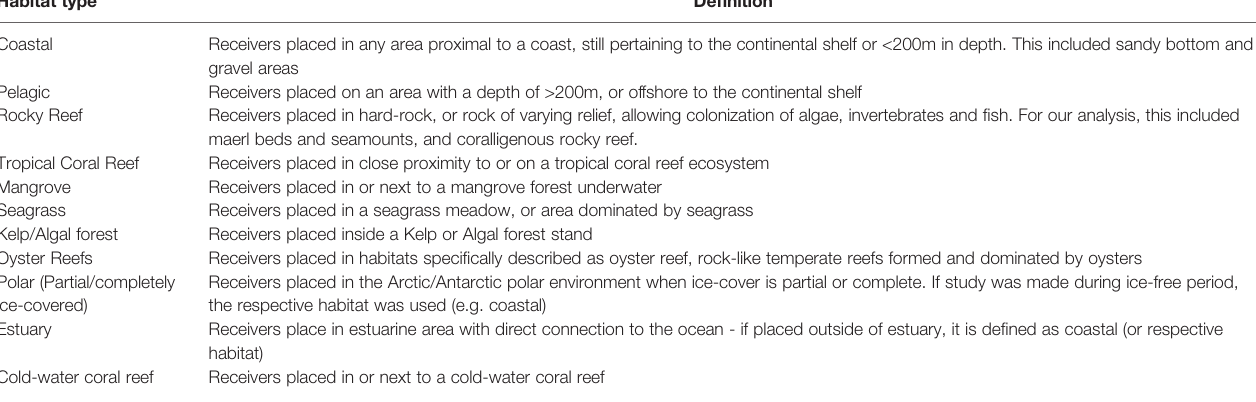
TABLE 1 | Habitat types and relative de fi nitions upon which soundscapes were classi fi ed. Habitat